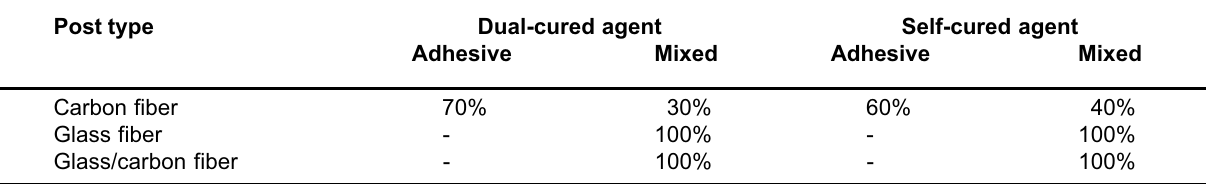
Means followed by different uppercase letters in the same row and lowercase letters in the same column were significantly different at p<0.05. Values are expressed in MPa. TABLE 2- Results of the failure mode analysis